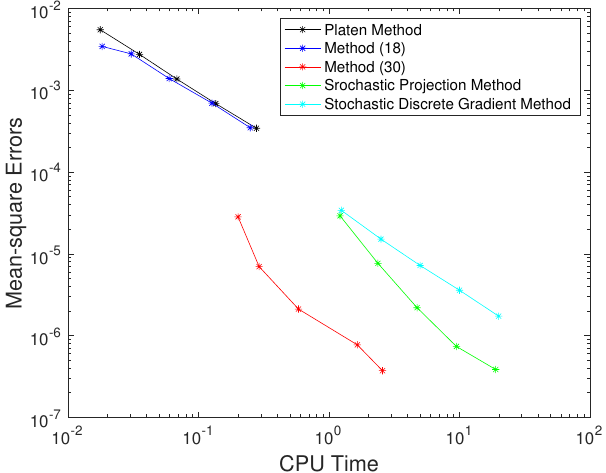
Figure 2. Mean-square sample errors and CPU time of the stochastic projection method, the stochastic discrete gradient method, the Platen method, method (18), and method (30).